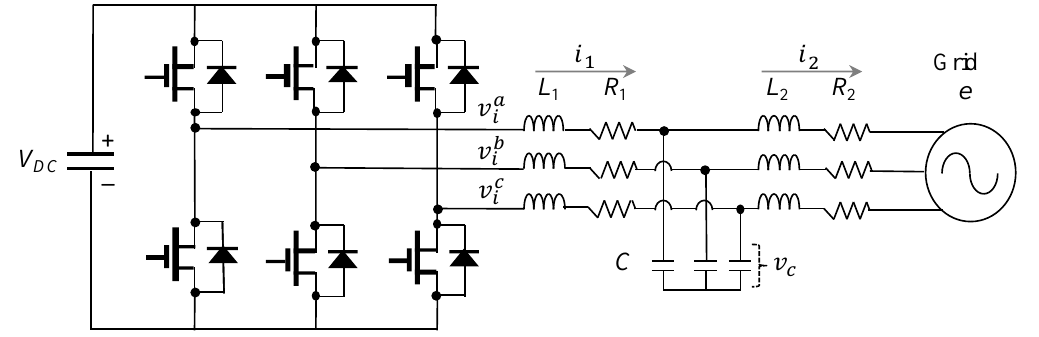
Figure 1. Configuration of a grid-connected inverter with inductive-capacitive-inductive (LCL) filter.